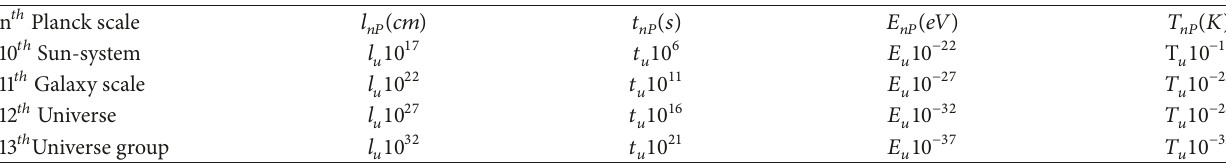
Table 2: Different characteristic times, energies, and temperatures for different matter strata from the star sun-system-scopic scale to universe group